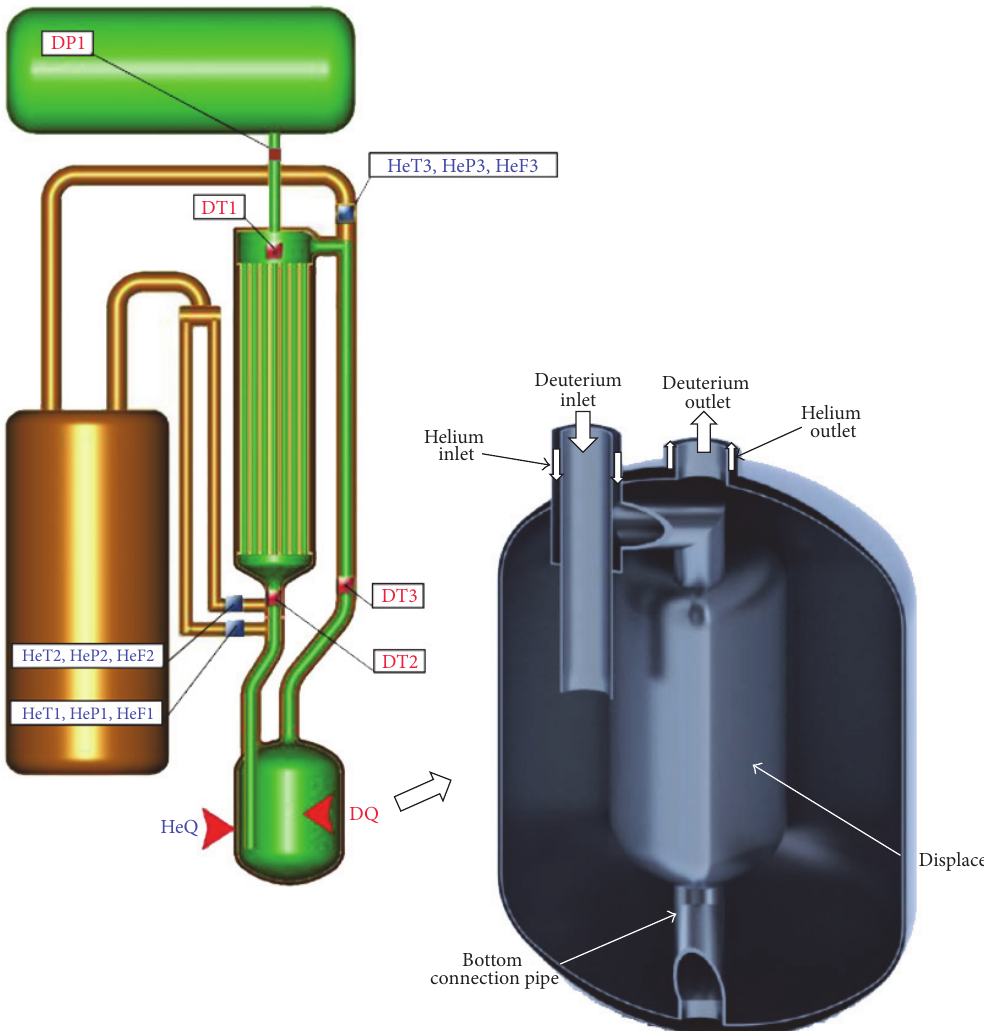
Figure 3: A full-scale experimental setup of the CNS thermosiphon system at PNPI and cross-sectional view of moderator cell, showing the